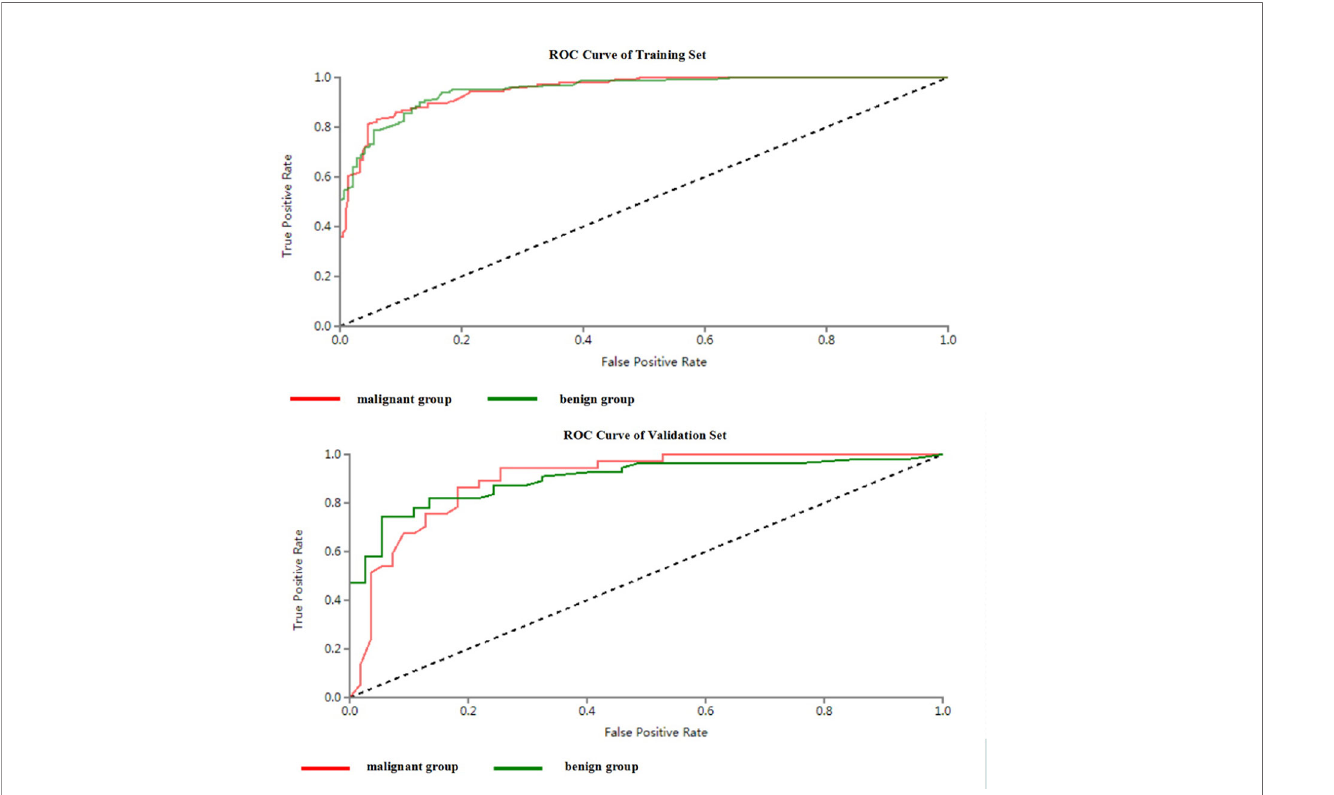
FIGURE 5 | ROC curves of SVM methods to classi fi cation (benign and malignant